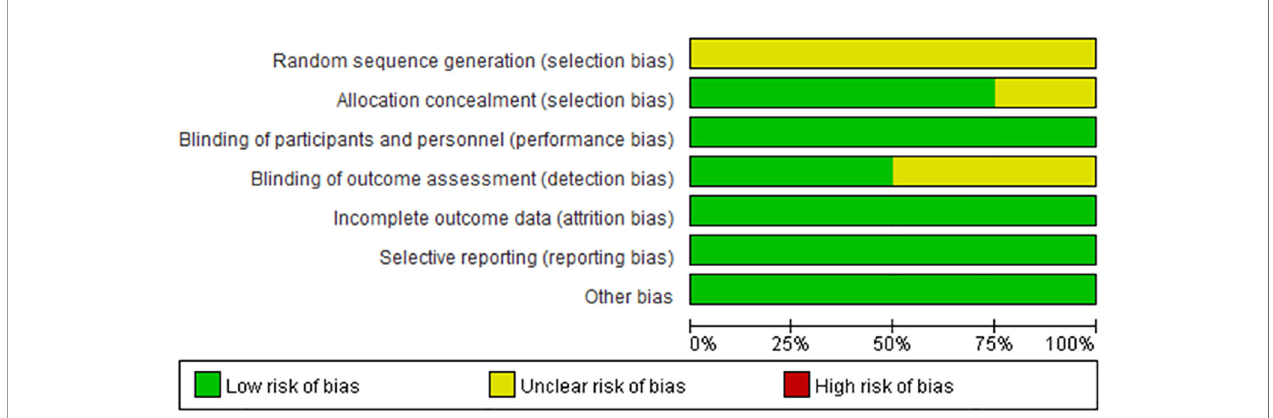
FIGURE 2 | Risk of bias summary. Green circles represent a low risk of bias; red circles represent a high risk of bias; yellow circles represent an unknown risk of